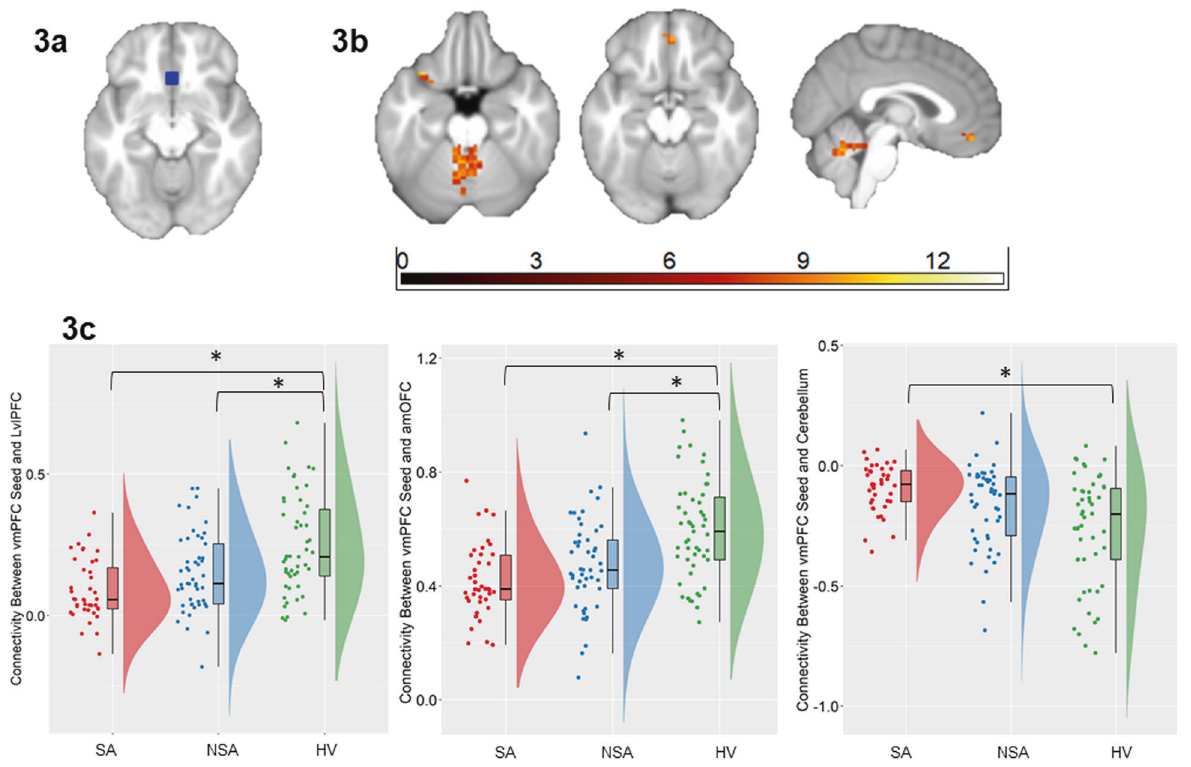
Fig. 3 Alterations in functional connectivity from the ventromedial prefrontal cortex associated with suicide attempts in bipolar disorder. The axial and sagittal images show regions of differences in functional connectivity from the ventromedial prefrontal cortex (vmPFC) seed region (Fig. 3a) to the left ventrolateral prefrontal cortex (LvlPFC), anteromedial orbitofrontal cortex (amOFC), and cerebellar vermis (Fig. 3b), using an ANCOVA analysis comparing individuals with bipolar disorder with history of suicide attempts (SA group; n = 40), individuals with bipolar disorder without suicide attempts (NSA group; n = 49) and healthy volunteers (HV; n = 51) ( p < 0.05, corrected for family-wise error). Left of fi gure denotes left side of brain. The color bar represents the range of F values. The raincloud plots (Fig. 3c) of distribution of extracted z-values from vmPFC-LvlPFC and vmPFC-amOFC clusters of differences in functional connectivity show the group differences resulted from lower connectivity from vmPFC to LvlPFC and to amOFC in the SA and the NSA groups, compared to the HV group. The raincloud plot (Fig. 3c) of distribution of extracted z-values from vmPFC-cerebellum show the group differences resulted from lower negative functional connectivity in the SA group compared to the HV group ( p < 0.05, corrected for 3 pair-wise group